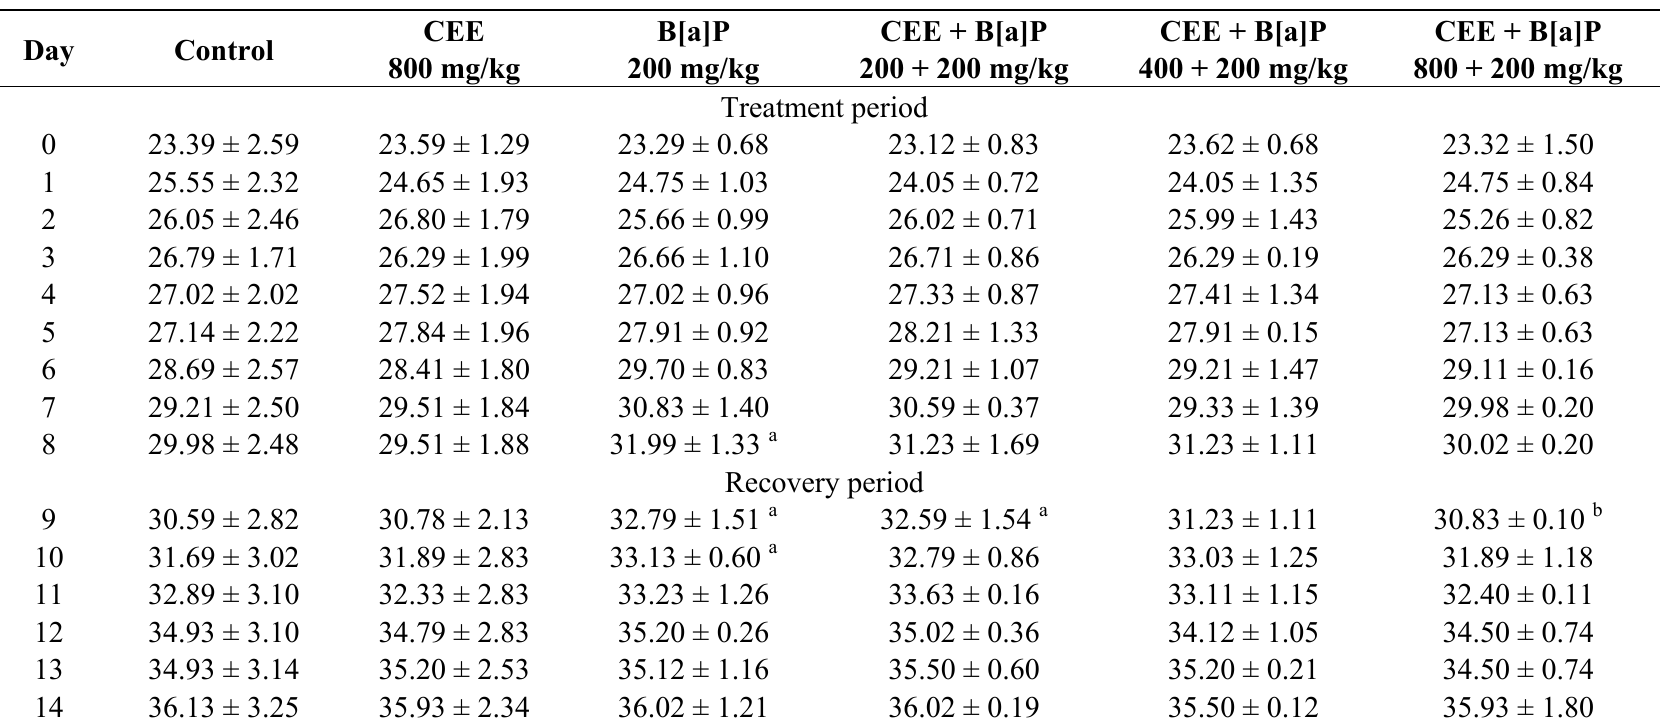
Table 1. Weight gain (g) in mice treated with cranberry ethanolic extract (CEE) and benzo[a]pyrene (X ±